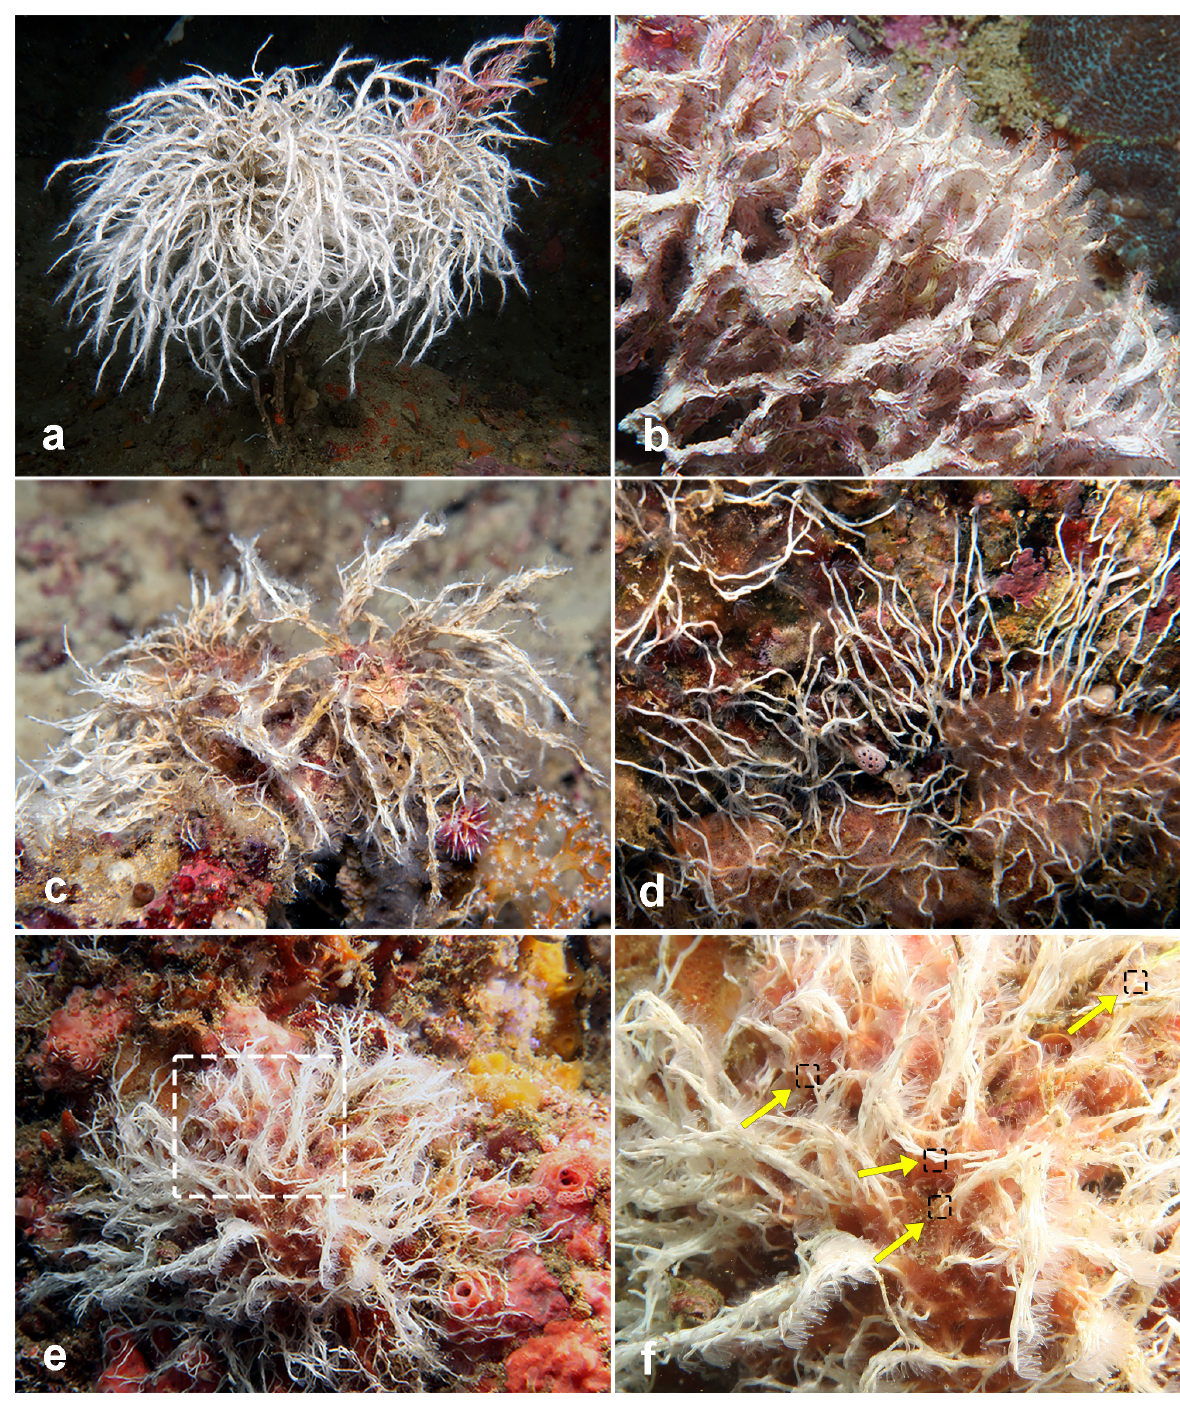
Figure 4. Filograna/Salmacina aggregations south of Oman, Dhofar region. ( a ) Worm clusters over- growing black coral stem. ( b – e ) Aggregations growing over rocks, crustose coralline algae, and sponges. ( f ) Square outline in figure e, showing the branching asexual pattern, as described by Per- net [24]) (photos M. Claereboudt, G. Paulay).